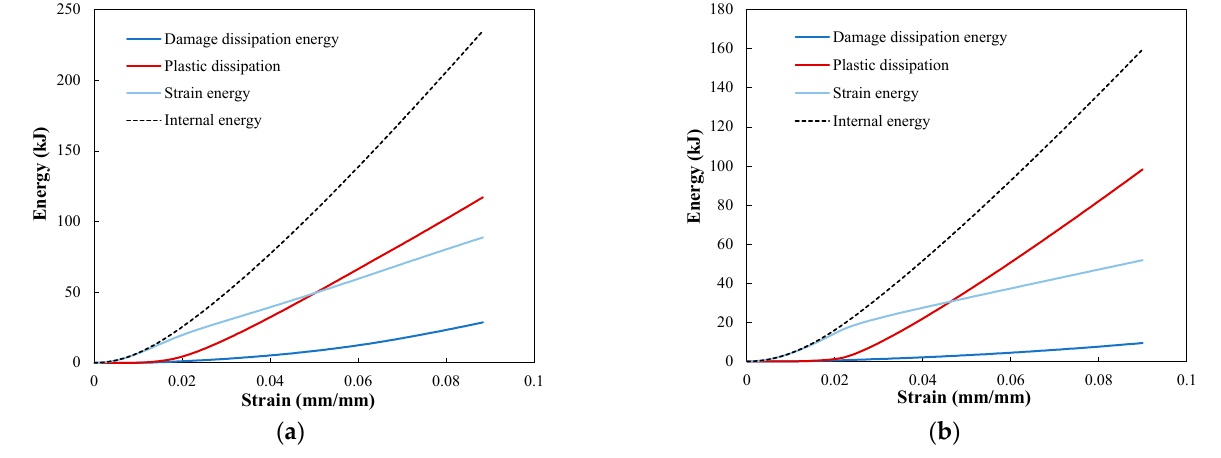
Figure 13. Comparison of energy dissipated by cohesive damage and plasticity of the matrix with elastic strain energy for ( a ) loading in the wale direction and ( b ) loading in the course